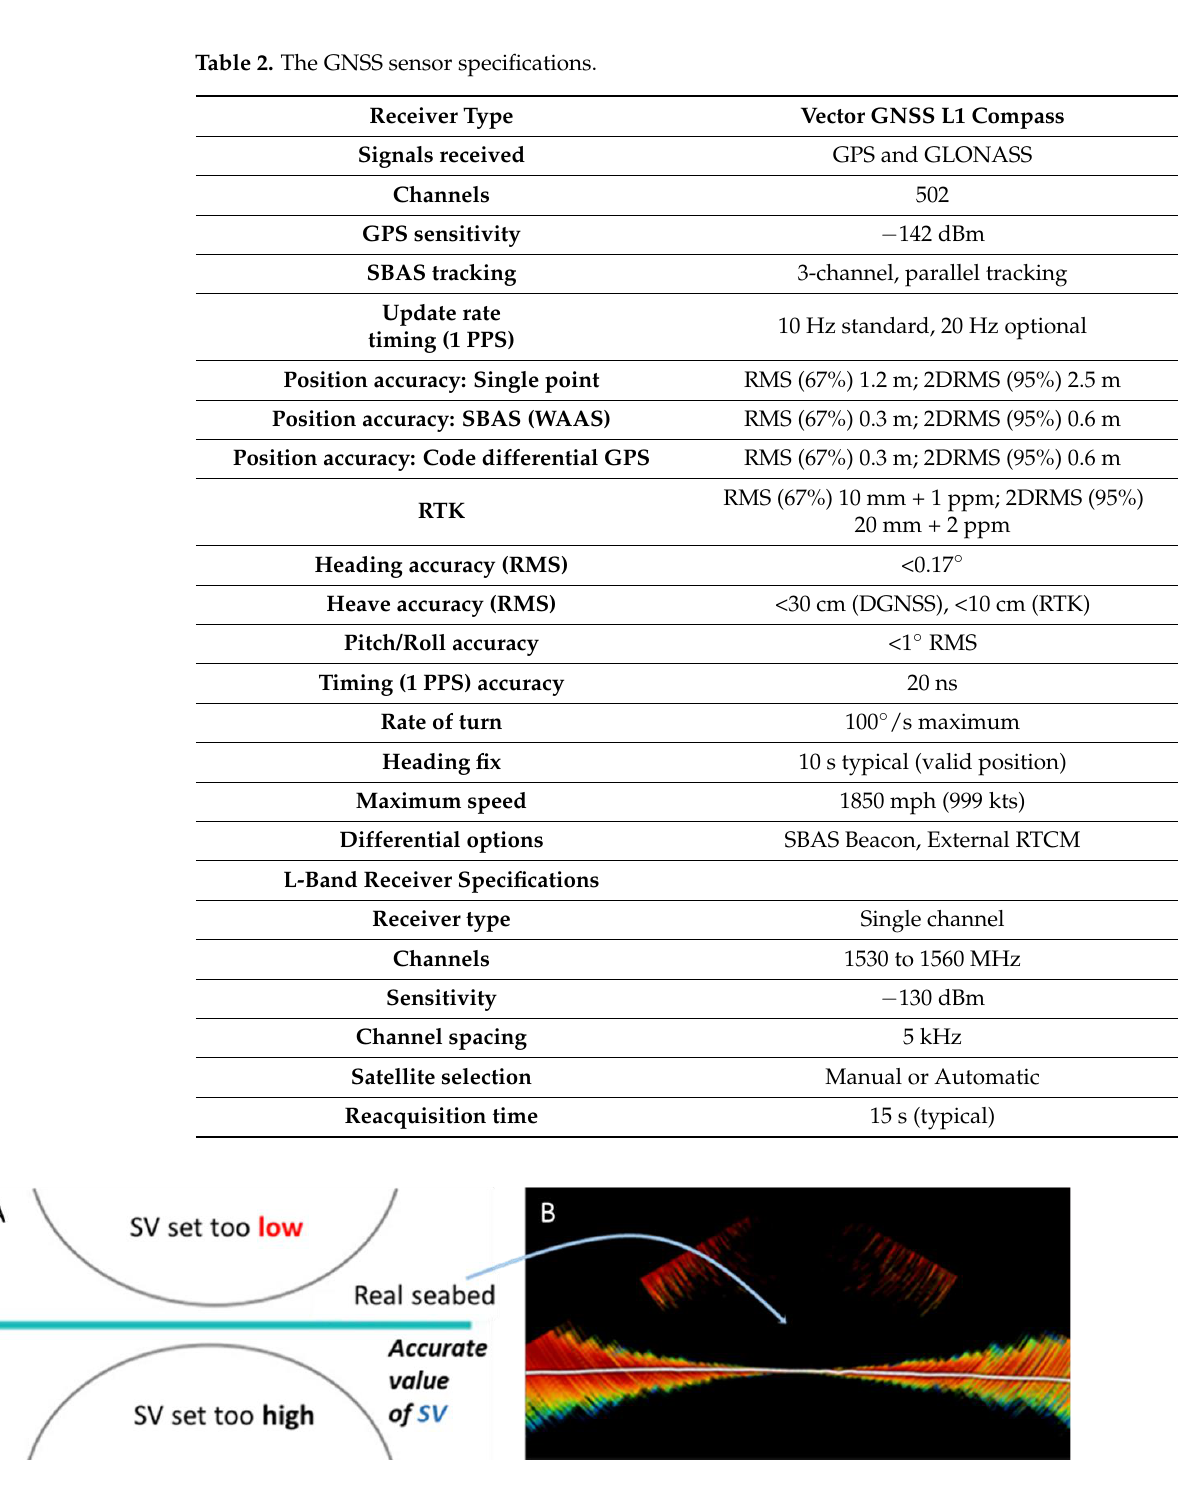
Figure 7. An example of: ( A ) the inaccuracies of the seafloor display due to incorrect SV; ( B ) an accurate value of SV.